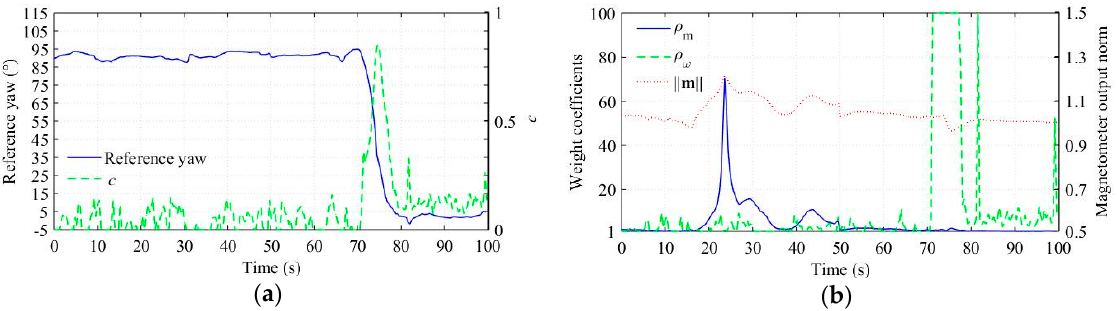
Figure 4. Adaptive weight coefficient based on the vehicle status. ( a ) Reference yaw and c . Because the reference yaw and c have different value range, two vertical axes are used for clarity with the right one corresponding to c . ( b ) ρ m and ρ ω . The magnetometer output norm is also plotted to show the relationship between magnetic disturbances and ρ m , and, similar to ( a ), two vertical axes are used with the right one corresponding to (cid:107) m (cid:107) . To obtain a proper vertical axe limit and thus the trends of curves can be showed clearly, the maximum value of the weight coefficients is set to 100.